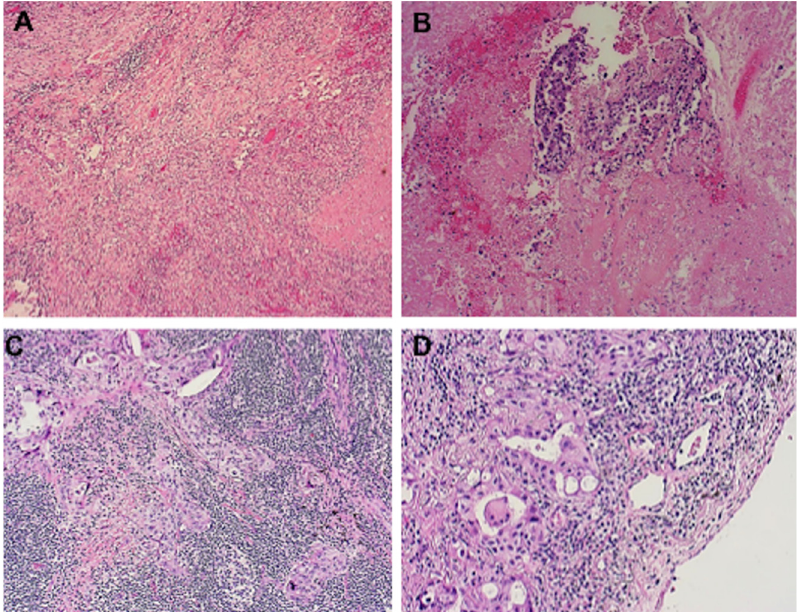
Figure 4. Microphotograph showing the histological features in patients who received ICIs (pem- brolizumab, ( A ) hematoxylin & eosin, H&E x100, and ( B ) H&E x250 ) or TKIs (erlotinib, ( C ) H&E x100 and ( D ), H&E x400 ). In both cases ( A , C ), it is evident the presence of massive fibrotic scar tissue with high concentration of lymphocyte infiltration, and the presence of rare tumor foci ( B , D ).